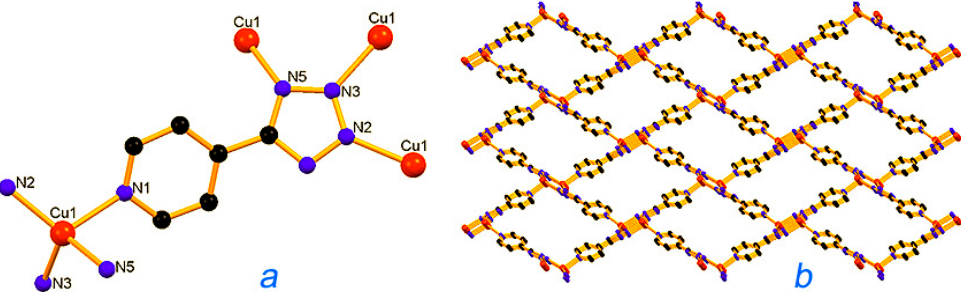
Figure 13. Structural fragments of the Cu(I) catalyst [Cu(mu 4 -4-ptz)] n [4-ptz = 5-(4-pyridyl)tetrazolate], 18 , representing ( a ) the basic unit; ( b ) a view of rhomboid voids along the a -axis. Adapted from Ref. [238].